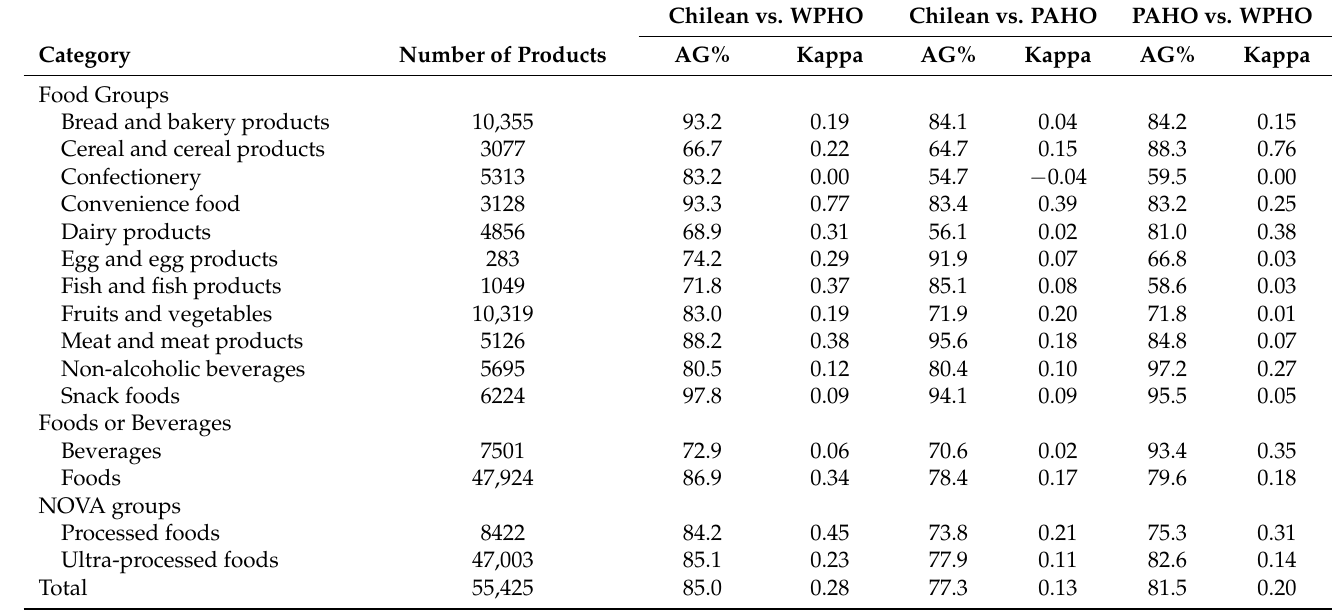
Table 5. Agreement between pairs of nutrient profile models by food categories. Chilean vs. WPHO Chilean vs.